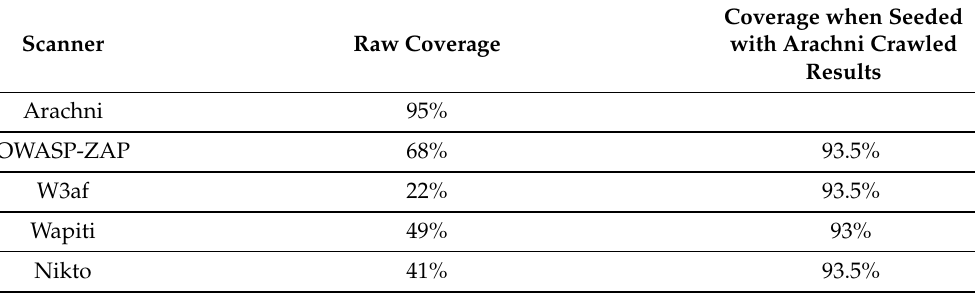
Table 7. Site coverage rate before and after using Arachni